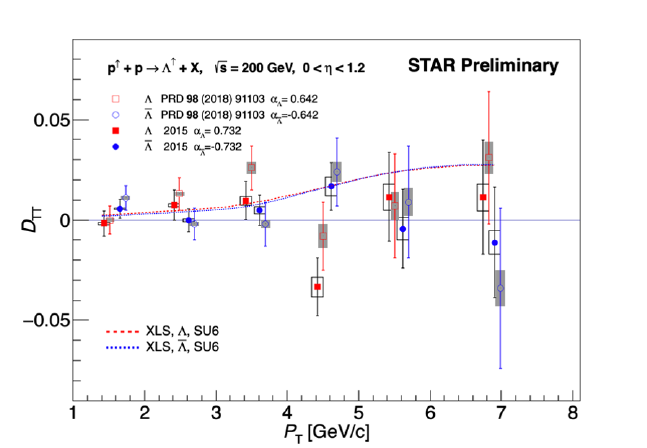
Figure 3: Preliminary results of D together with previously published results. The ¯ Λ results and the previously published results have been shifted slightly to larger p